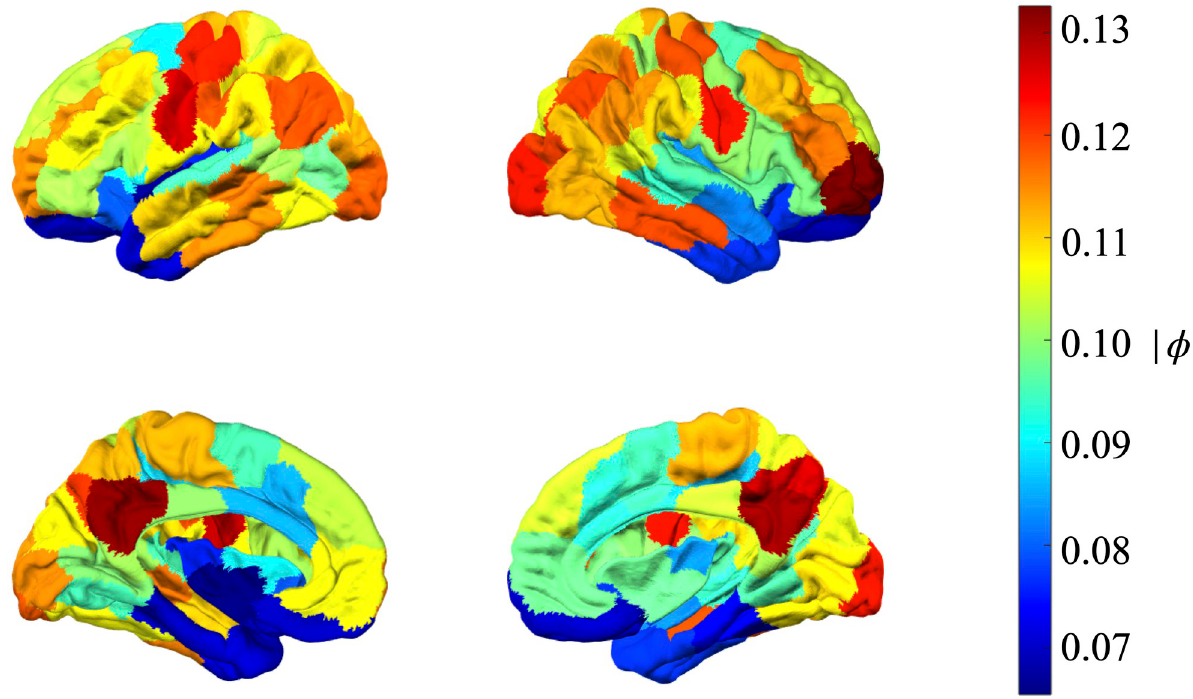
Fig 2. Mean value of the absolute AR(1) parameter averaged across all 98 subjects across all 4